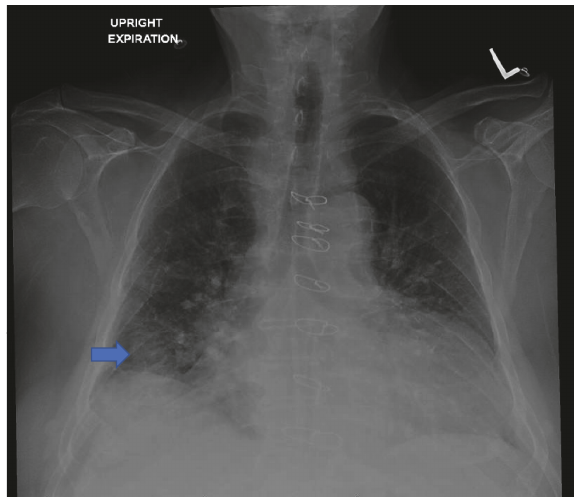
Figure 1: CXR upright-expiration. Arrow: right lower lobe irregular mass like opacity, no evidence of pneumothorax, effusion, or consolidation.